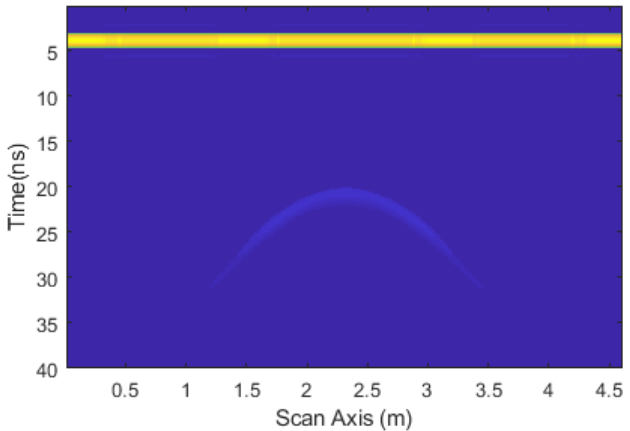
Figure 7. Frequency division section of GPR.